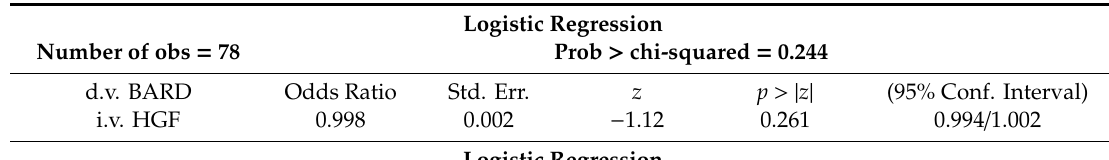
Table 11. Prediction of hepatic steatosis or NAFLD severity using BARD score > 2 by HGF, spleen length, indices of indirect calorimetry.